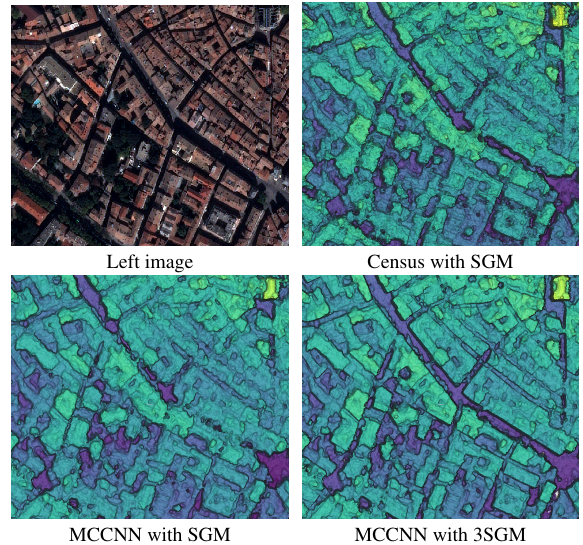
Figure 5. Annotations produced by the manual and automatic annotation strategies: red points indicate ”Buildings” class while green ones indicate ”Not buildings”